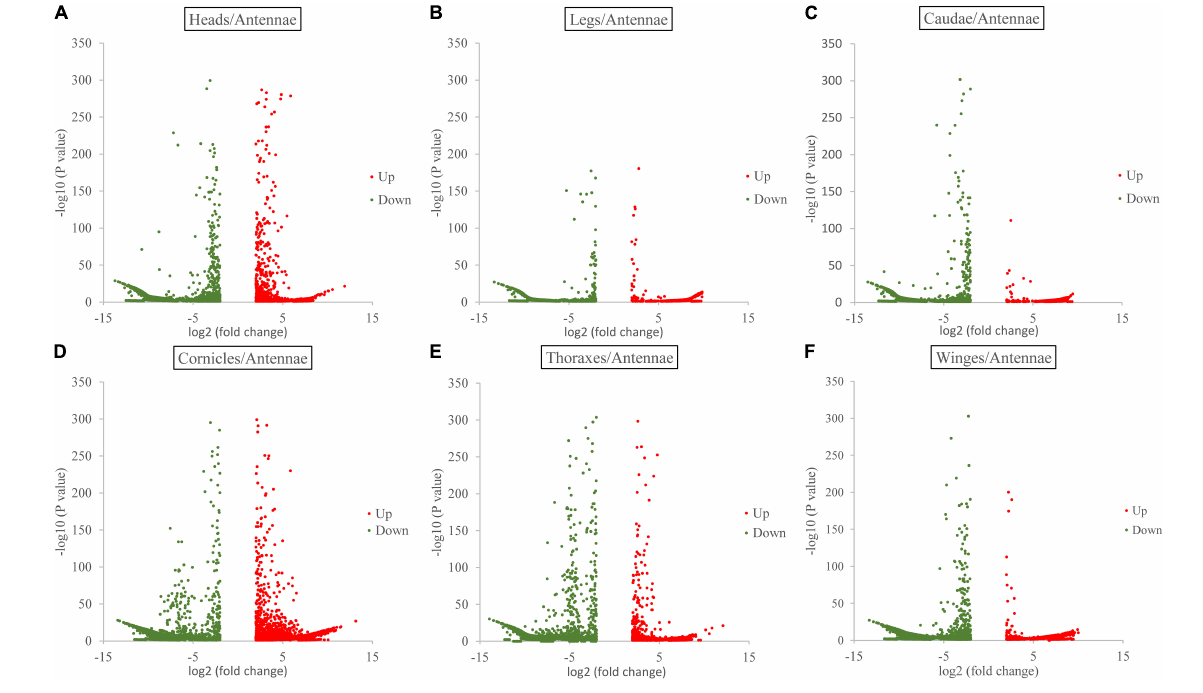
Frontiers in Physiology |